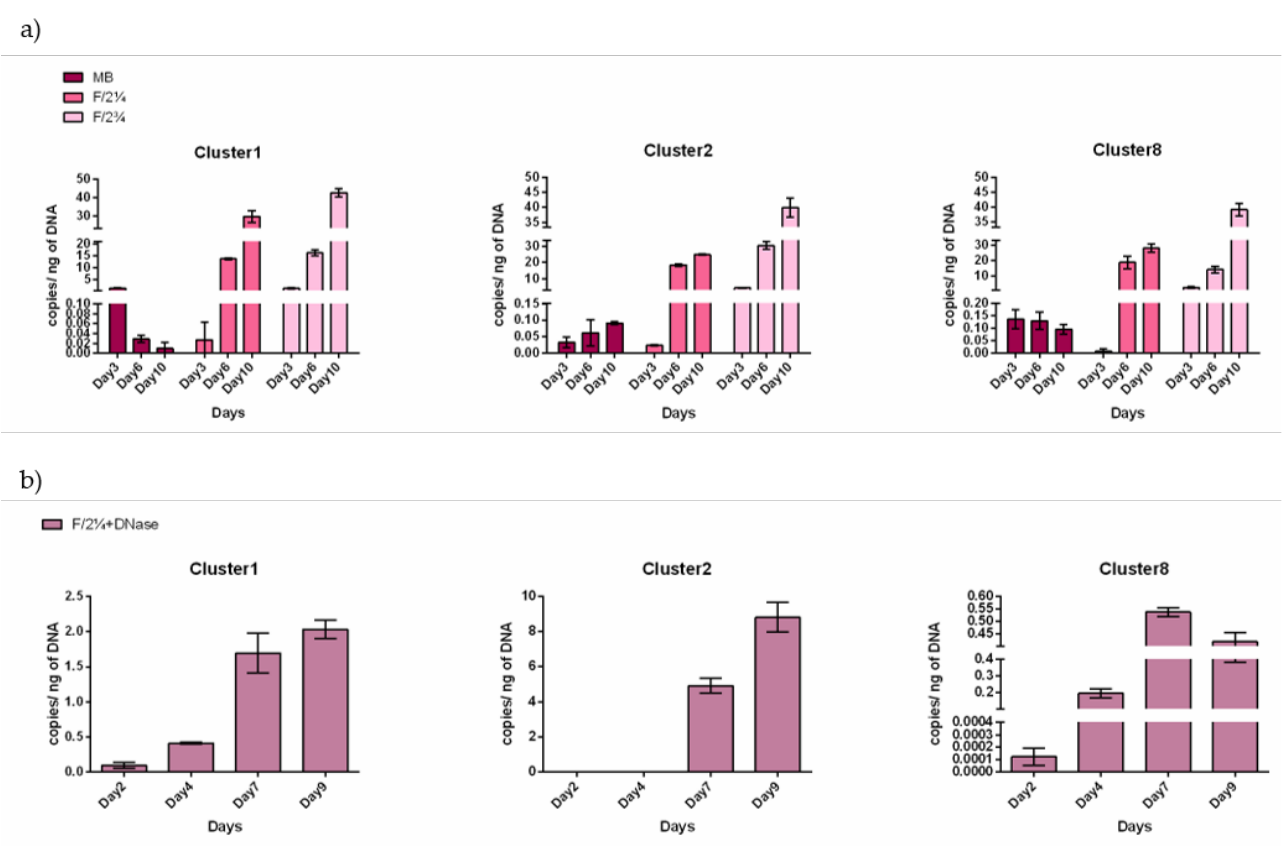
Figure 8. Diatom-free MAG growth. ( a ) qPCR amplification of Cl-1, Cl-2 and Cl-8 specific sequences from gDNA extracted from FL bacteria separated from S. marinoi FE7 cultures grown in marine broth supplemented with spent medium (MB), or in F/2 medium supplemented with different concentrations of sonicated S. marinoi -FE7 cells (F/2¼ and F/2¾ ) (see M&M for details). Sampling time points: 3rd (Day3), 6th (Day6) and 10th (Day10). ( b ) qPCR amplification of Cl-1, Cl-2 and Cl-8 on gDNA extracted from FL bacteria grown in F/2 1 media previously treated with DNase. Sampling time points: 2nd (Day2), 4th (Day4), 7th (Day7) and 9th